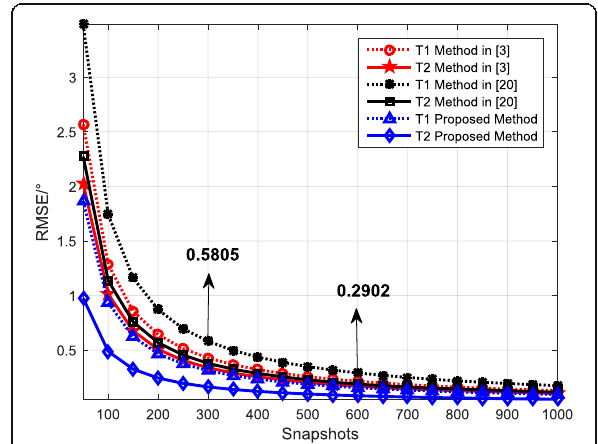
Fig. 7 RMSE versus snapshots with the SNR fixed at 10 dB